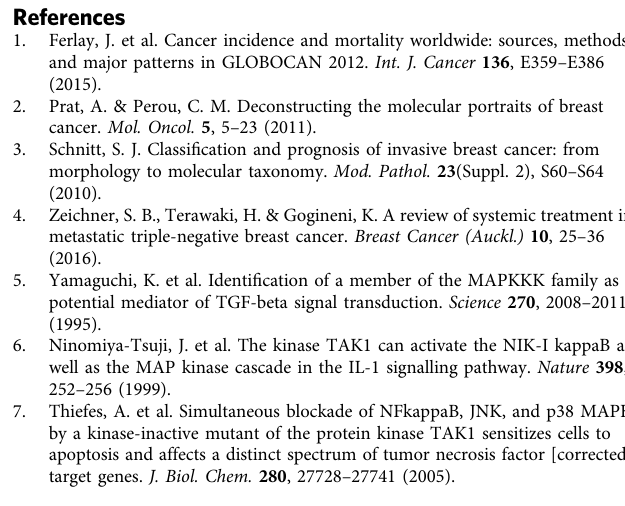
Statistical analysis . Statistical analysis was performed using the GraphPad Prism. Data from at least three independent experiments are expressed as means± SD unless stated otherwise. Normal distribution was assumed and Student's t test was applied for two-component comparisons, using Welch correction when groups with different variances were compared. One-tailed statistical analyses were per- formed in mouse experiments addressing the ef fi cacy of a treatment in reducing metastatic burden. Two-tailed analyses were used for other experiments. Con- fi dence level of 0.95% was used for all statistical analyses ( α -value = 0.05). No statistics was applied to determine sample